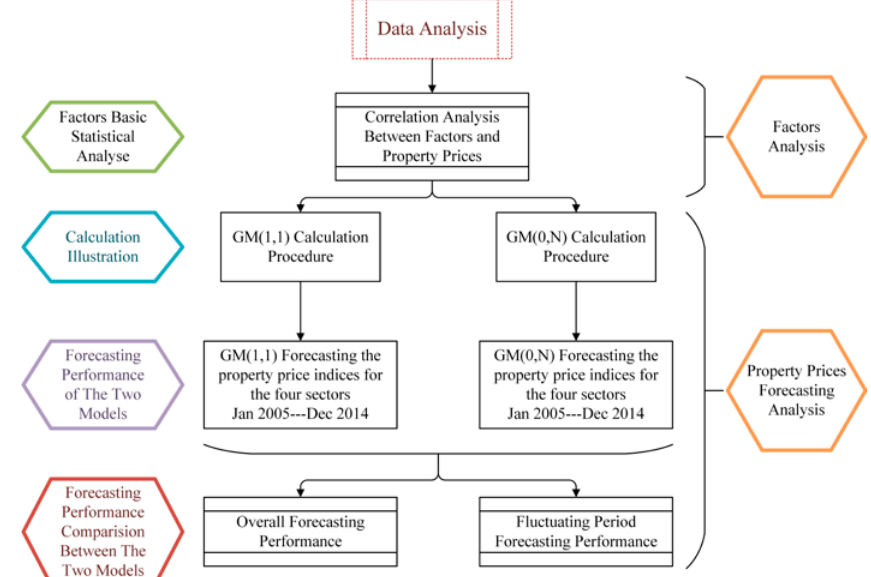
Fig. 2. Main steps of data